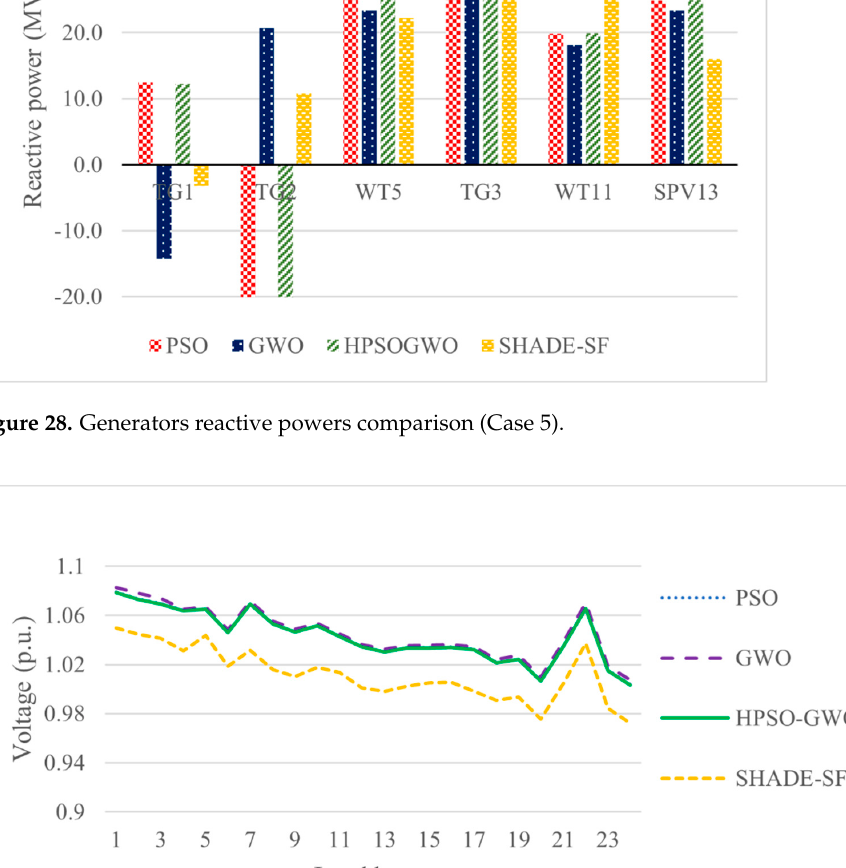
Figure 29. Load buses voltage profile comparison (Case 5).